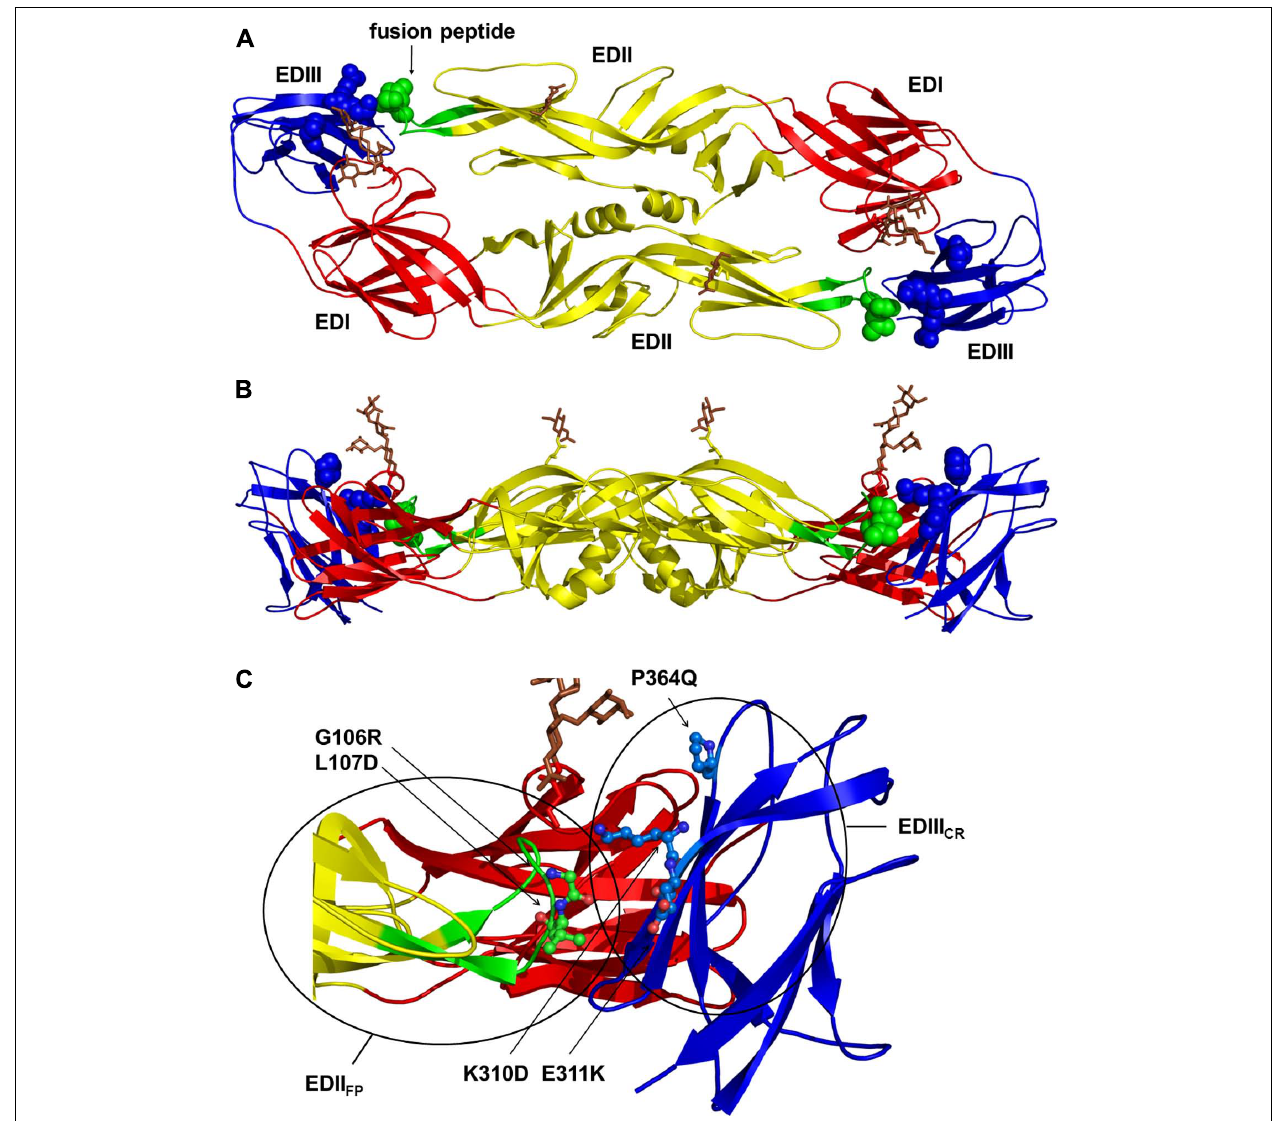
FIGURE 1 | Structural locations of the pVD1-CRR envelope (E) protein cross-reactive epitope knock out substitutions. The locations of the DENV-1 E substitutions introduced to construct pVD1-CRR mapped on the crystal structure of the homologous DENV-2 E protein dimer (Modis etal., 2003). (A) Locations of pVD1-CRR substitutions (spheres) on a ribbon diagram of the mature E dimer as it appears looking straight down toward the virion surface.The three structural domains are labeled and colored red for E domain I (EDI), yellow for EDII, and blue for EDIII.The EDII fusion peptide (EDII FP ) is also labeled and colored green.The glycans in EDI (N67) and EDII